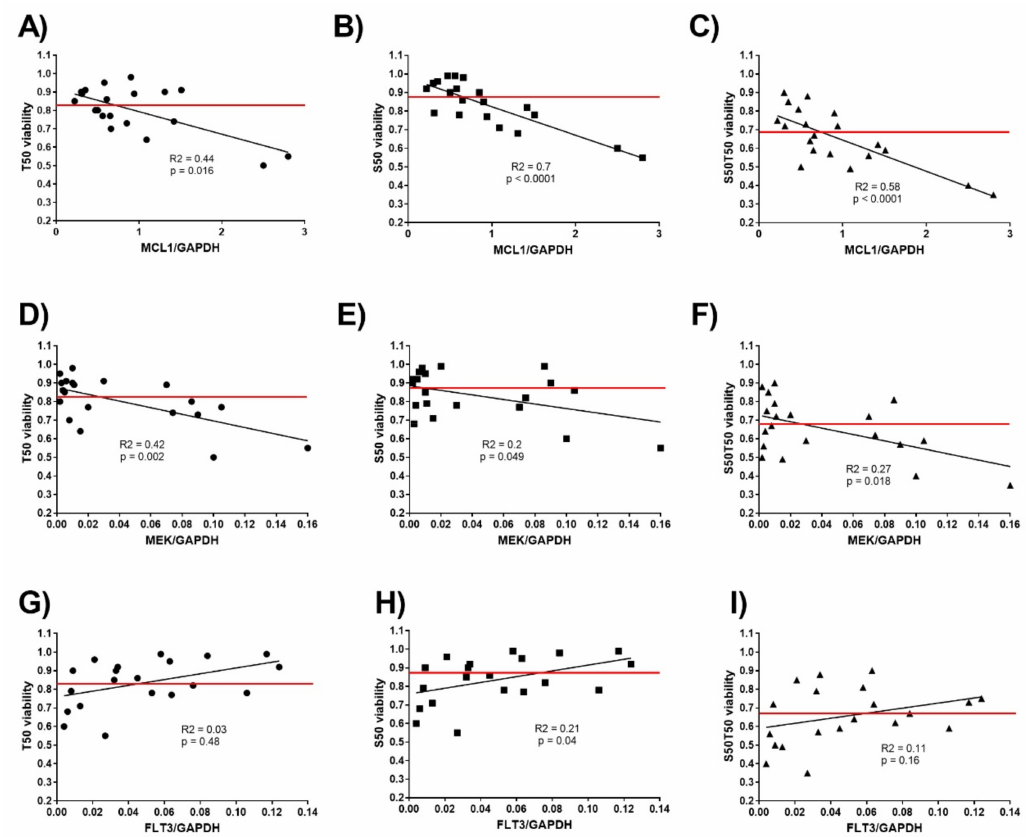
Figure 6. Correlation of viability and biomarker expression in mononuclear cells isolated from 16 patients with hematological malignancies and 4 AML cell lines treated with S63845 and trametinib. Relative protein levels of MCL1 / GAPDH ( A – C ), MEK / GAPDH ( D – F ), and FLT3 / GAPDH ( G – I ) in mononuclear cells of patients with hematological malignancies in correlation to cell viability after 20-hour treatment with 50nM S63845 (S50), 50nM trametinib (T50), or combination treatment (S50T50). Hematological cells with elevated MCL1-protein levels are susceptible to S63845 and trametinib, while hematological cells with elevated MEK-protein levels are susceptible to trametinib. The threshold of sensitivity (red line) was deliberately set at median levels of cell